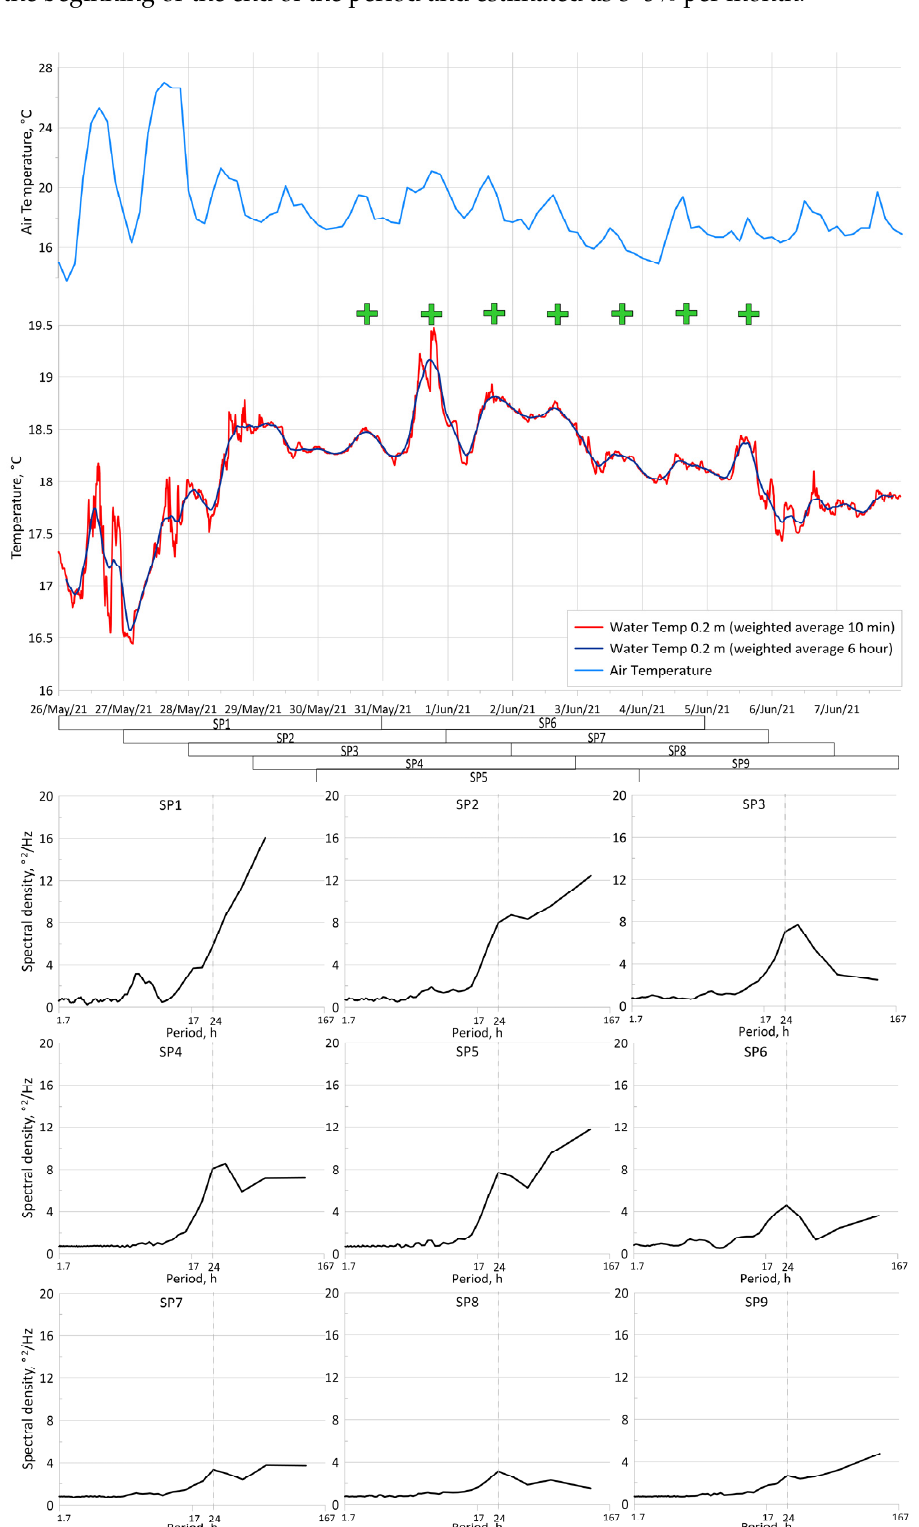
Figure 11. Diurnal cycle of the water and air temperature. Rectangles (SP1 … SP9) below x -axis show 5-day moving periods for spectra calculation. Green crosses show days with the visually confirmed diurnal cycle. Bottom panel: examples of nine spectra from 26 May to 7 June 2021.